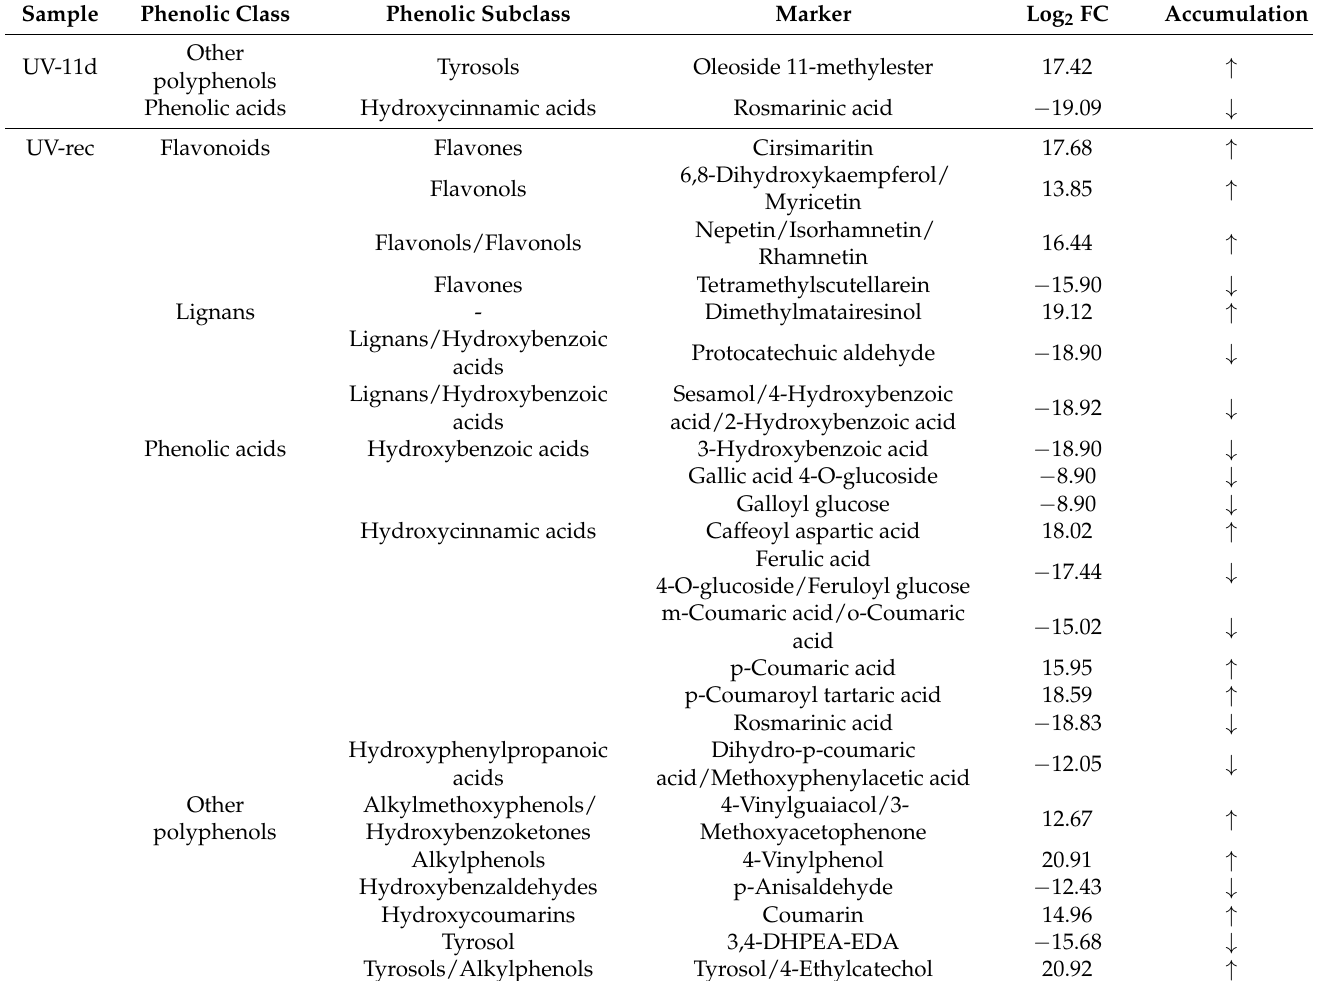
Table 5. List of the phenolic compounds in UV-treated leaves, selected by combining analysis of variance and fold-change into volcano plot (Benjamini–Hochberg multiple testing correction, p < 0.05; fold-change cut-off = 1.2). The symbols “ ↑ ” and “ ↓ ” mean increased and decreased accumulation,